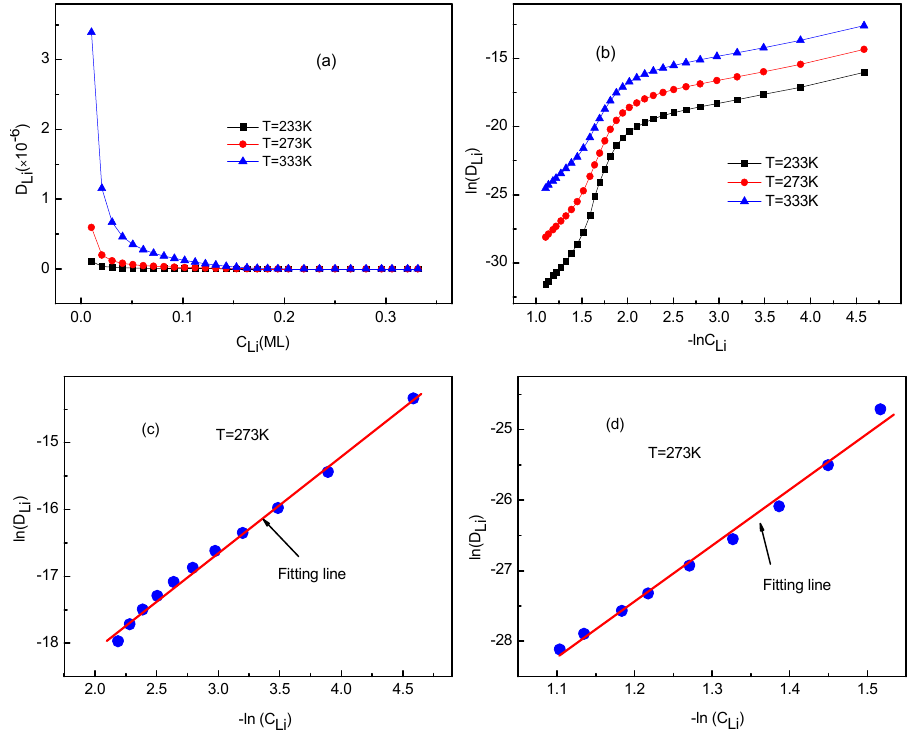
Figure 6. ( a ) The diffusion coefficient D Li as a function of Li + concentration C Li ; ( b ) the logarithm of D Li as a function of the logarithm of C Li , at T = 233, 273 and 333 K. The logarithm ln( D Li ) as a function of − ln( C Li ) for C Li for ( c ) low concentration region, and ( d ) high concentration region at T = 273 K. The solid lines are the fitting ones. Table 1. The slope β and correlation coefficient r 1 for the linear fitting line between ln( D Li ) and ln( C Li ) in different region of concentration C Li (ML) at various temperatures.